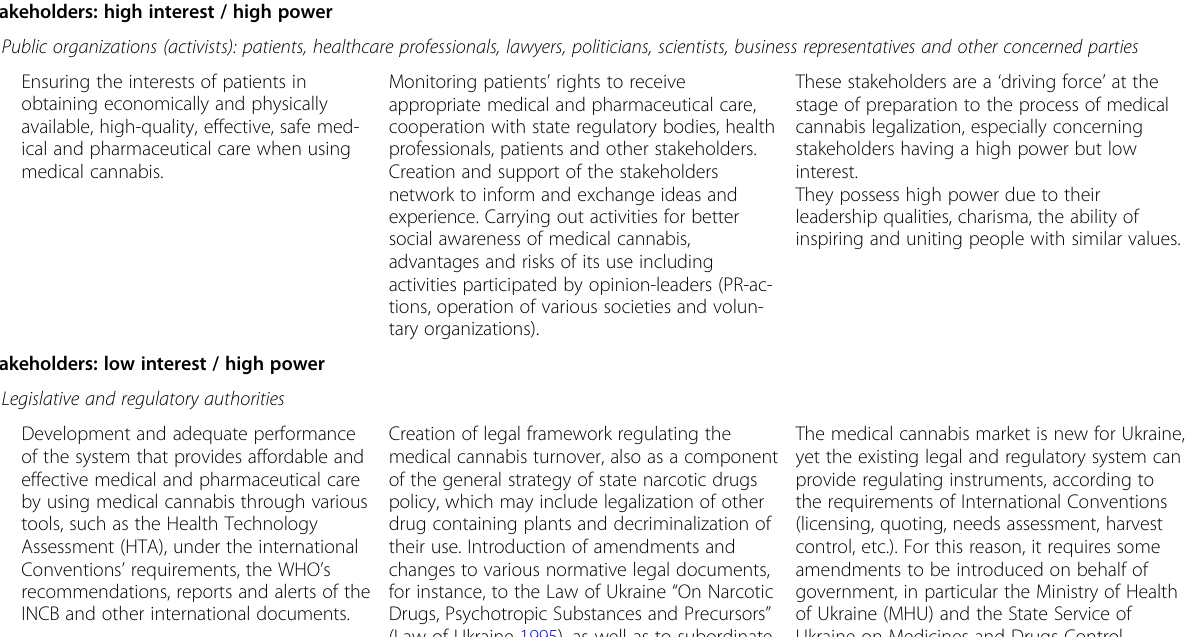
Table 2 Expectations and predictable actions of the key stakeholders in the medical cannabis market in